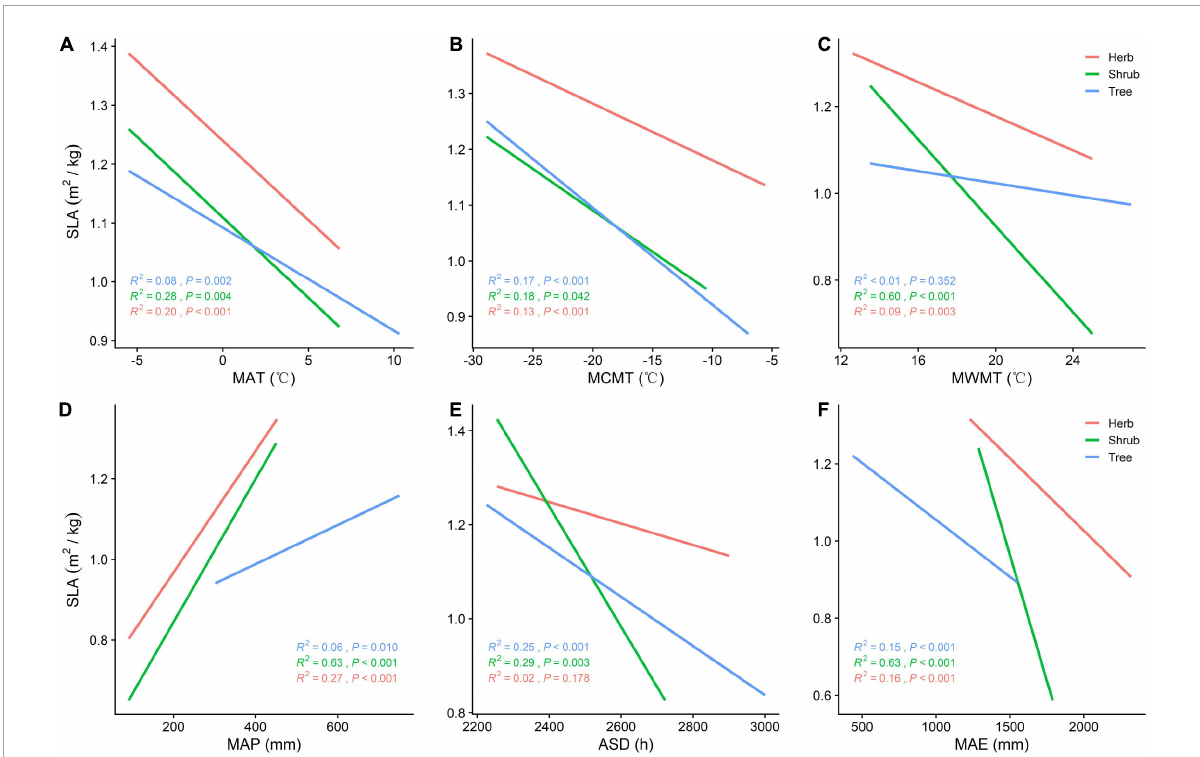
FIGURE3 (A) General linear relationship between MAT and SLA of plants in the trees, shrubs, and herbs; (B) general linear relationship between MCMT and SLA of plants in the trees, shrubs, and herbs; (C) general linear relationship between MWMT and SLA of plants in the trees, shrubs, and herbs; (D) general linear relationship between MAP and SLA of plants in the trees, shrubs, and herbs; (E) general linear relationship between ASD and SLA of plants in the trees, shrubs, and herbs; (F) general linear relationship between MAE and SLA of plants in the trees, shrubs, and